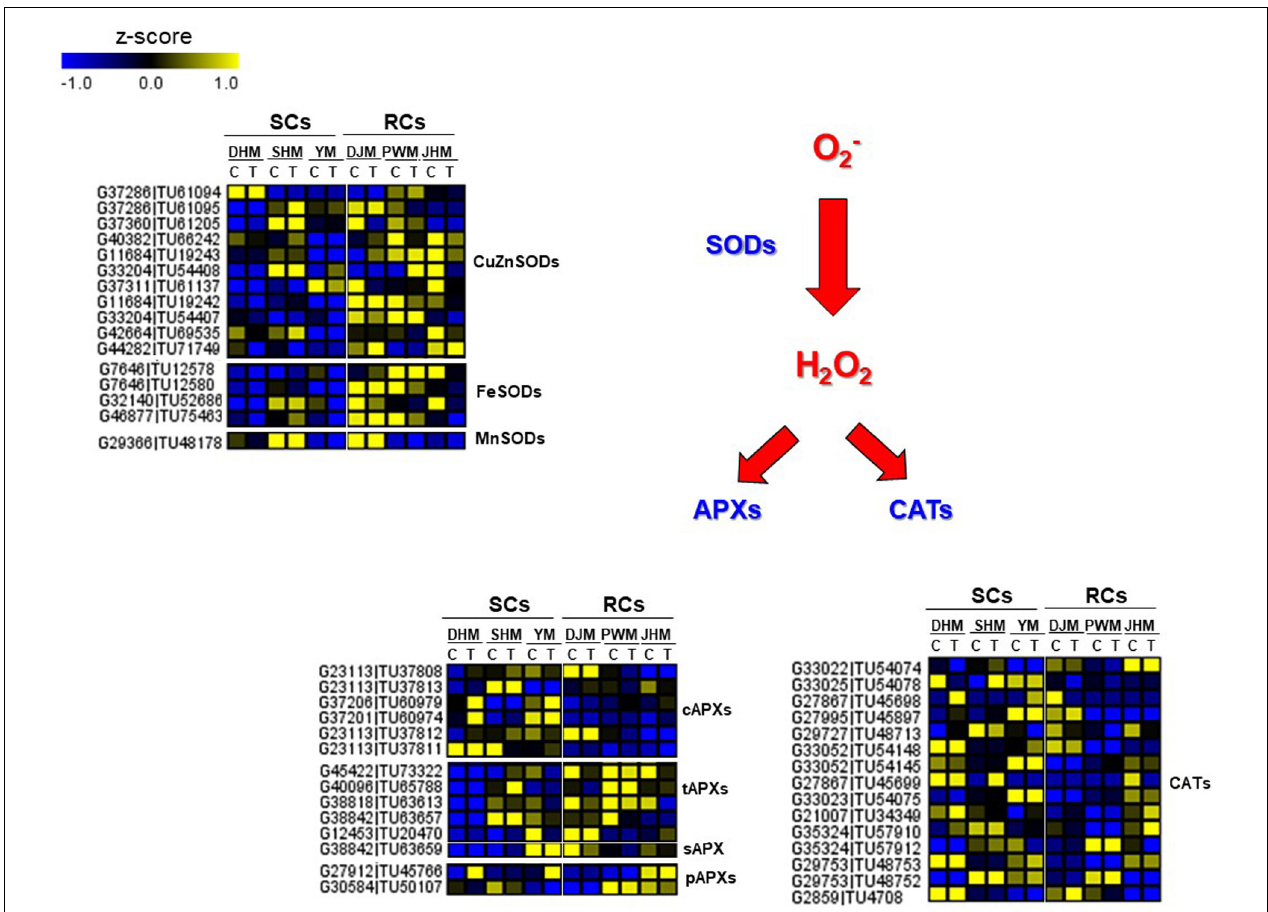
FIGURE 10 | Comparison of the relative expression levels of ROS-related genes in six sweetpotato cultivars under control and RKN-infected conditions. DEGs included the following ROS-related genes. SOD, superoxide dismutase; CuZnSOD, copper zinc SOD; FeSOD, iron SOD; MnSOD, manganese SOD; APX, ascorbate peroxidase; CAT, catalase; cAPX, cytosolic APXs; tAPX, thylakoid APX; sAPX, stroma APX; pAPX, peroxisomal APX. Cultivars were DHM, Dahomi; DJM, Danjami; PWM, Pungwonmi; SHM, Shinhwangmi; JHM, Juhwangmi; YM, Yulmi. Abbreviations are RCs, resistant cultivars; SCs, sensitive cultivars; C, control; T, treatment. The heatmap was constructed using Multi Experiment Viewer